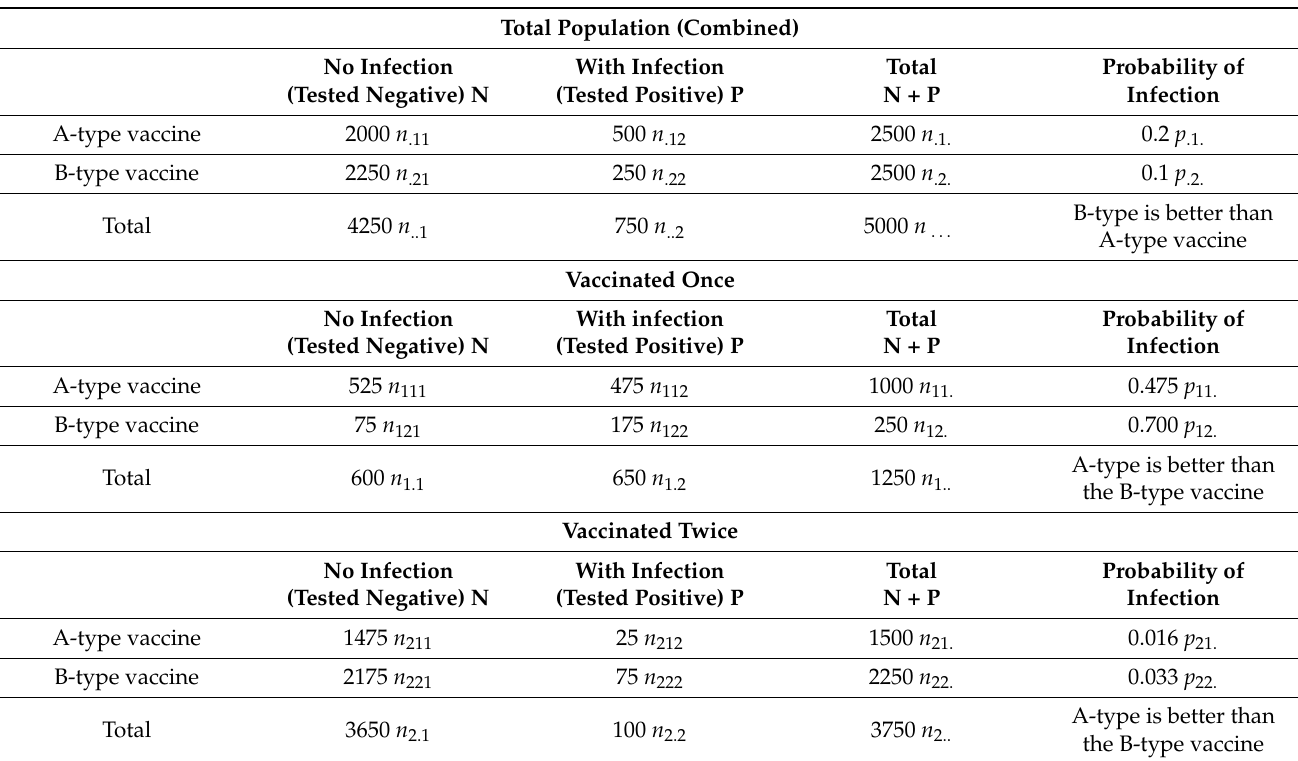
Table 1. Frequencies for determining the unreliability of the effect of vaccination (probability of infection after vaccination in the observed